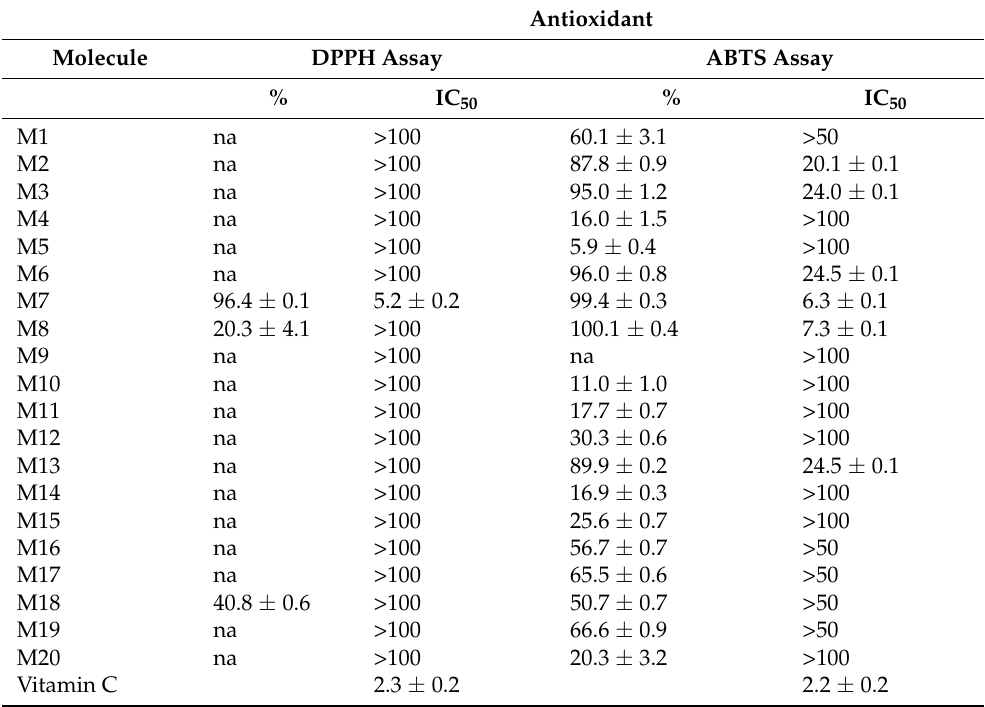
Table 2. Antioxidant activity (DPPH and ABTS assays) of flavones (percentage at 100 µ M and IC 50 ( µ M)). na: not